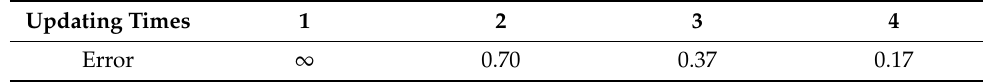
Table 1. Error values at each update of the domain dictionary.